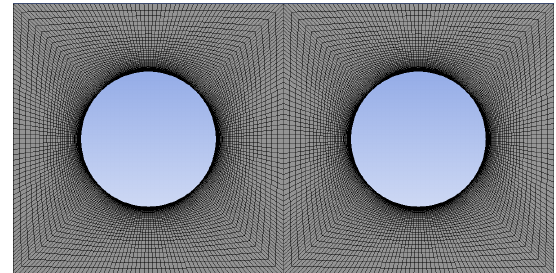
Figure 3. Close-up of the mesh near the cylindrical